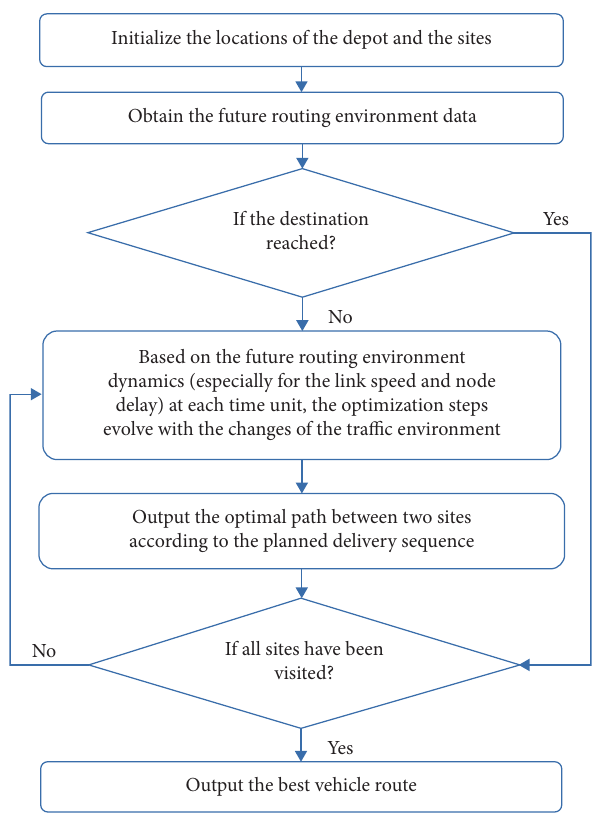
Figure 1: The framework of the optimization process for the CEPO